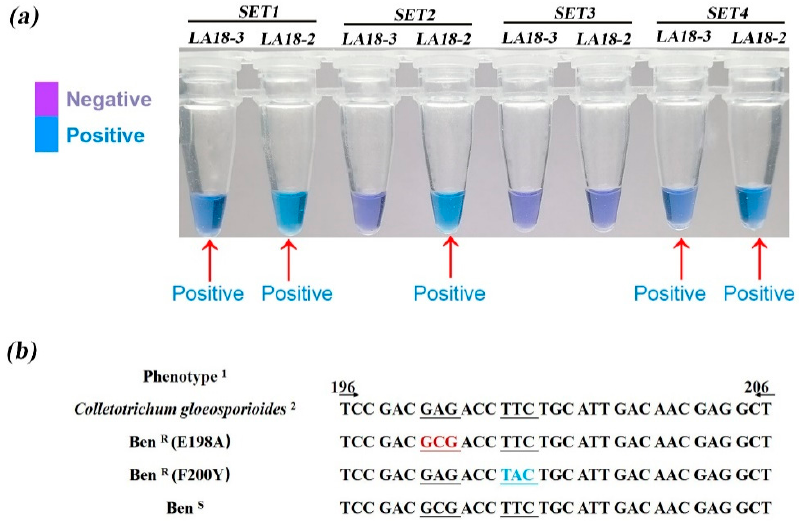
Figure 5. Genotypes of thiophanate-methyl-resistant isolates of Colletotrichum obtained from straw- berry nurseries: ( a ) LAMP primer set screening and assessment were based on HNB-visualized changes in colors. Positive samples are indicated by red arrows: LA18-3, a sensitive isolate without the E198A mutation; LA18-2, a highly resistant isolate carrying the E198A mutation. ( b ) Three geno- types of β -tubulin gene and alignment of partial gene sequences of the β -tubulin gene: 1 , thiophanate- methyl phenotype of Colletotrichum species; 2 , partial β -tubulin gene sequences of C. gloeosporioides , downloaded from the GenBank database (GenBank no. U14138.1); 196 and 206 indicated that codon 196 and codon 206 at β -tubulin gene, respectively; the base in red or in blue indicated that a point mutation at codon 198 and codon 200, respectively; E198A, codon at 198 change from GAG to GCG, resulting in a glutamic acid(E) to alanine(A) substitution; F200Y, codon at 200 change from TTC to TAC, resulting a phenylalanine(F) to tyrosine(Y) substitution; Ben R, the isolates carrying point mu- tations E198A or F200Y were resistant to thiophanate-methyl.